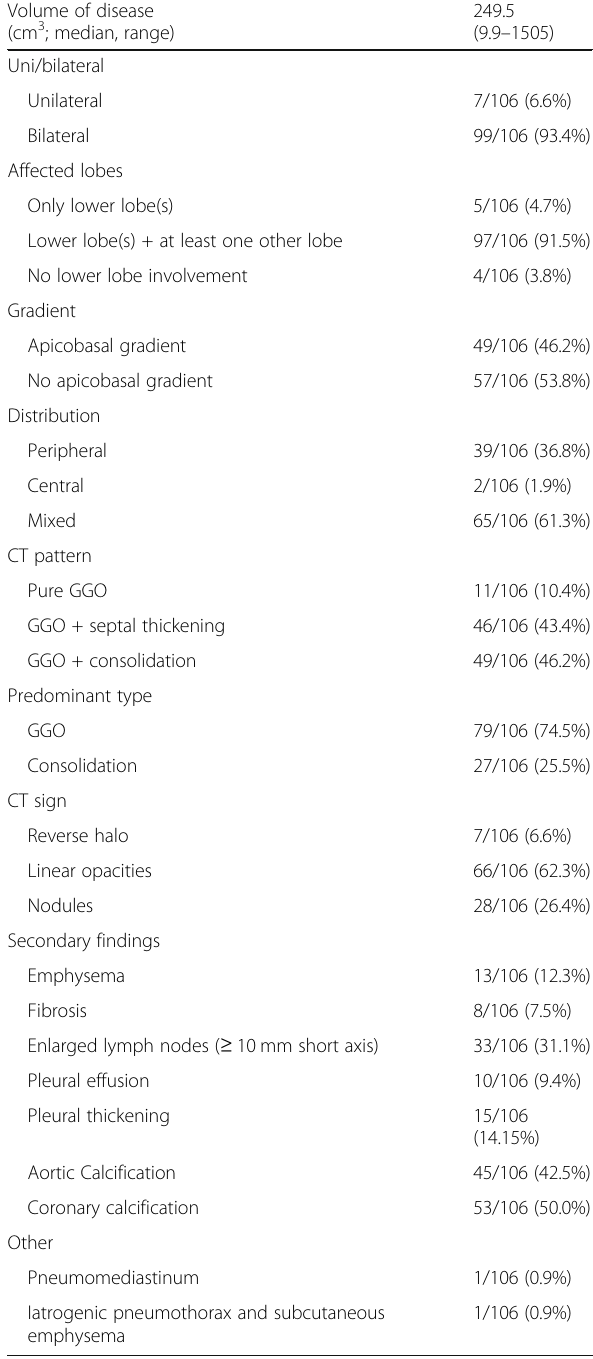
Table 2 Quantitative and qualitative computed tomography (CT) findings related to COVID-19, and secondary CT findings Volume of disease (cm 3 ; median,